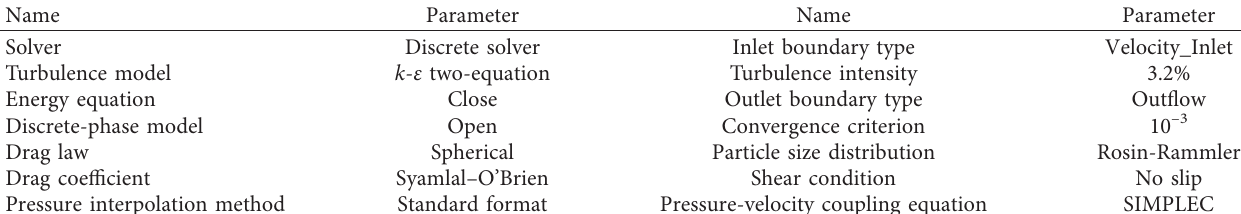
Table 2: Boundary conditions of the geometric model.